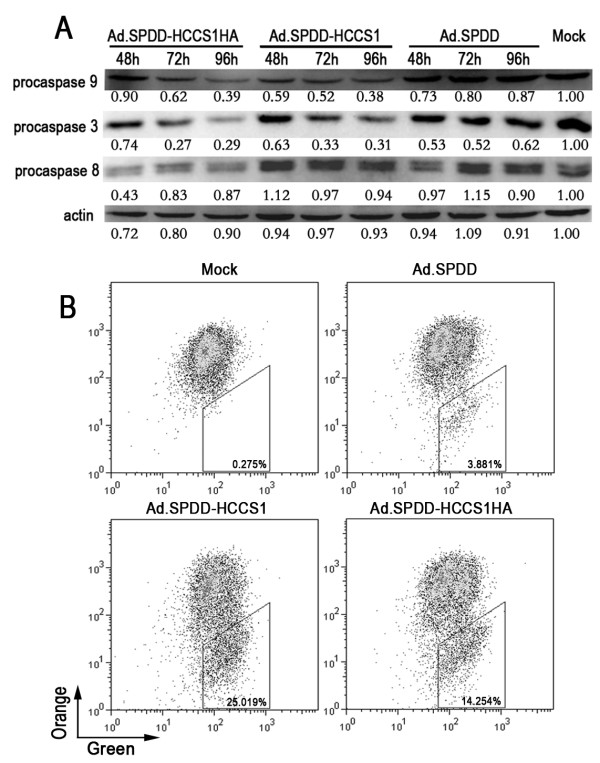
Ad.SPDD-HCCS1 induces mitochondrial-mediated apoptosis in liver cancer cells. (A) Western blot analysis of apoptosis-related proteins in Huh-7 cells infected with Ad.SPDD, Ad.SPDD-HCCS1 or Ad.SPDD-HCCS1HA. Actin was used as a loading control. (B) Ad.SPDD-HCCS1 and Ad.SPDD-HCCS1HA induced an increased loss of mitochondrial membrane potential in Huh-7 cells. The mitochondrial membrane potentials of the Huh-7 cells infected with the indicated viruses were analyzed by JC-1 staining via FACS detection. The percentage of cells in the trapeziform region is shown as cells with lost mitochondrial membrane potential.